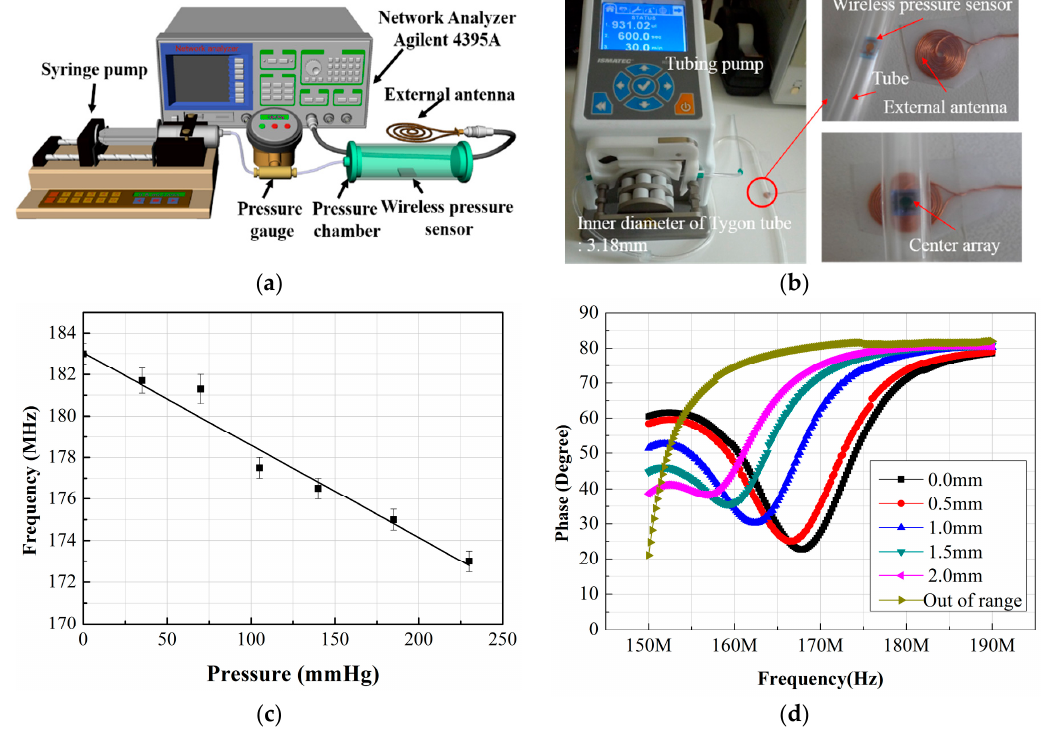
Figure 6. ( a ) Schematic of the experimental setup; ( b ) photographs of a fabricated sensor placed in a pressure-controllable tube; ( c ) resonance frequency variation as a function of the applied pressure; ( d ) phase as a function of frequency with different working distance between the sensor and the external antenna.